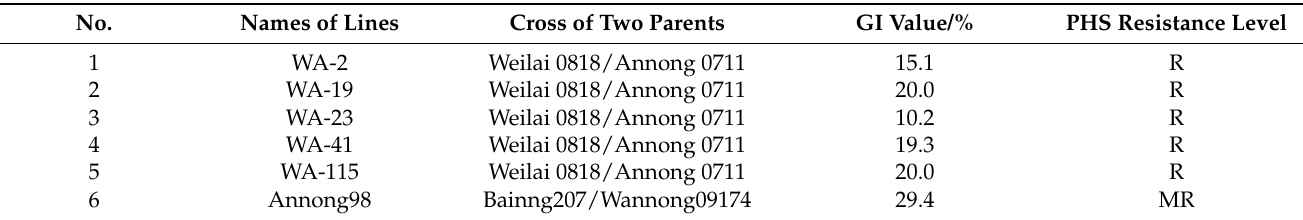
Table 3. The advanced lines of wheat with favorable pre-harvest sprouting resistance.